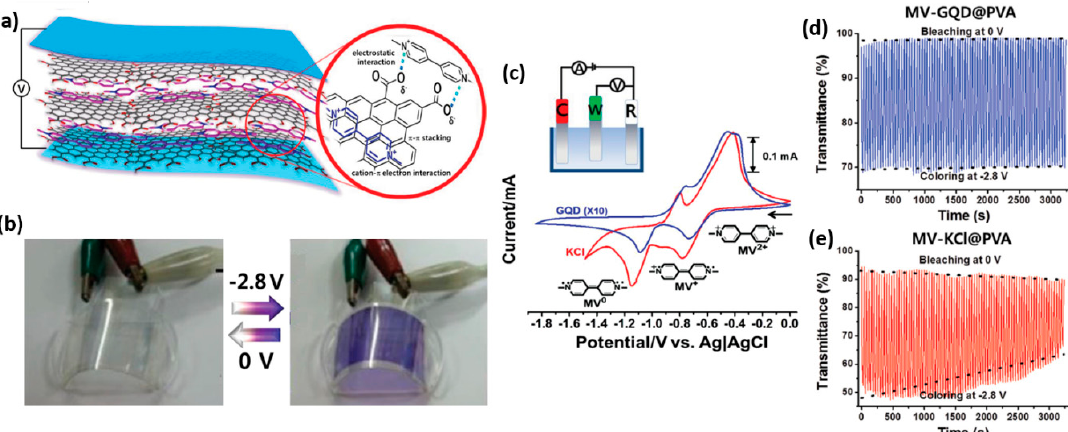
Figure 15. ( a ) Illustration of an electrolyte-free flexible electrochromic device of MV 2 + -GQDs. ( b ) Photographs for the reversible performance of a flexible MV 2 + -GQD EC device (containing 100 mM MV 2 + with 8 mg mL − 1 GQD in PVA) with ITO-on-PET. ( c ) Cyclic voltammetry of 5 mM MV 2 + at an ITO electrode in an aqueous solution containing 8 mg mL − 1 GQD (blue line) and 0.1 M KCl (red line) at a scan rate of 100 mV s − 1 . Voltage-controlled transmittance changes by voltage switching between 0 (a bleached state) and − 2.8 V (a colored state) for 50 mM MV 2 + in an ECD at 550 nm. EC device of ITO-on-glass electrodes were prepared with: ( d ) 8 mg mL − 1 GQD in PVA and ( e ) 0.1 M KCl in PVA. Readapted with permission from WILEY-VCH [105].